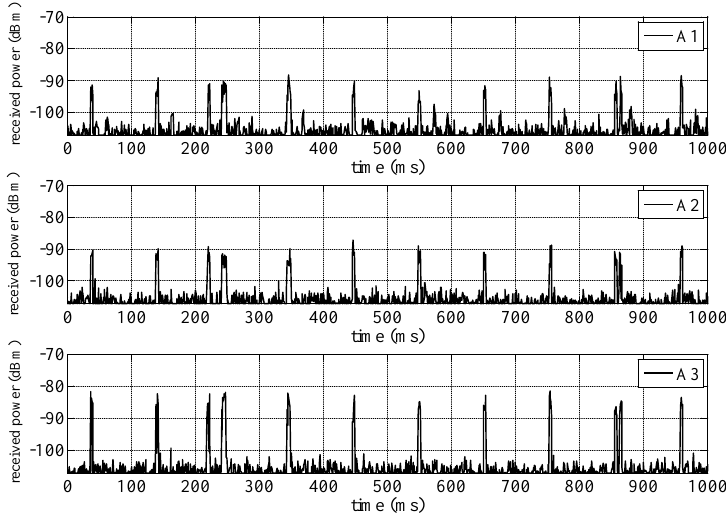
Figure 10. E ff ect of directional antenna on received power and short duration packets in channel ‘1’. Electronics 2019 , 8 , x FOR PEER REVIEW